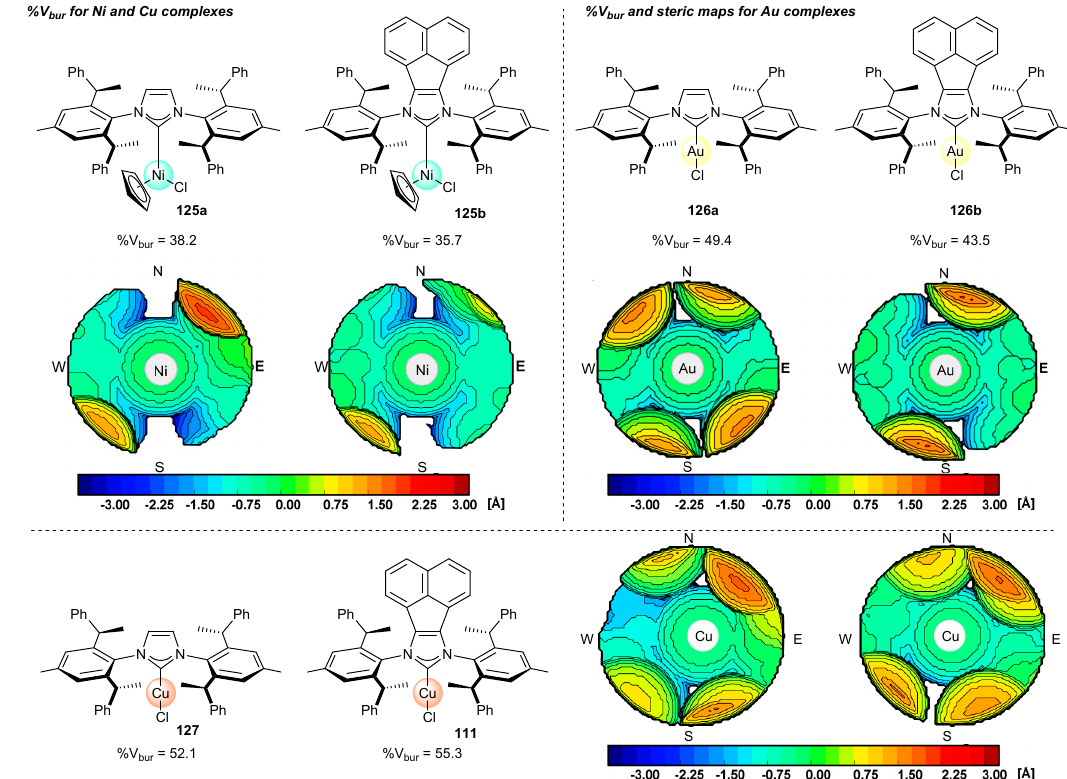
Figure 4. Comparison of %V bur and steric maps for Ni, Co and Au complexes. Adapted with permission from Ref [52] Diesel, J.; Finogenova, A. M.; Cramer, N. J. Am. Chem. Soc. 2018 , 140 , 4489-4493. Copyright 2021 American Chemical